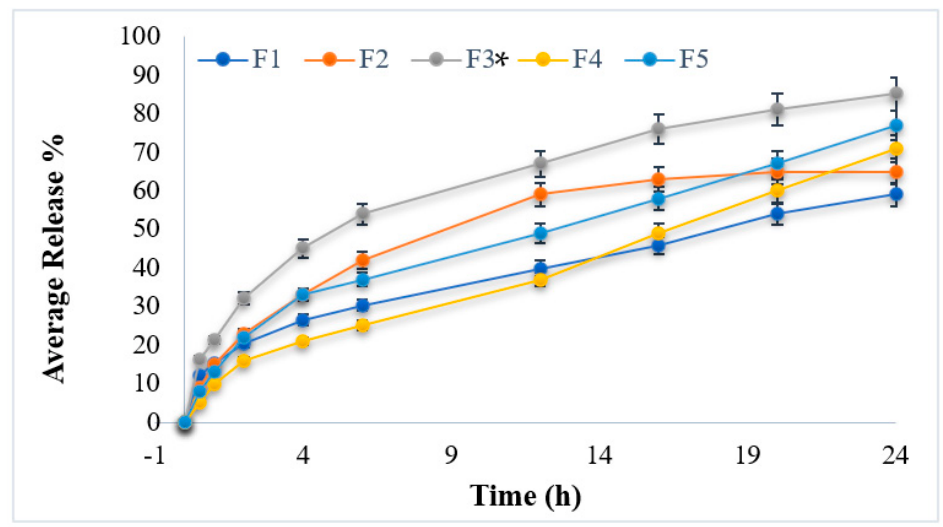
Figure 5. In vitro drug release of esomeprazole-loaded hydrogel formulations (F1–F5). Data are ex- pressed as mean ± SD; n = 3. One-way ANOVA followed by post hoc Tukey test ( p < 0.05), F5 vs. F1. (* p < 0.05).